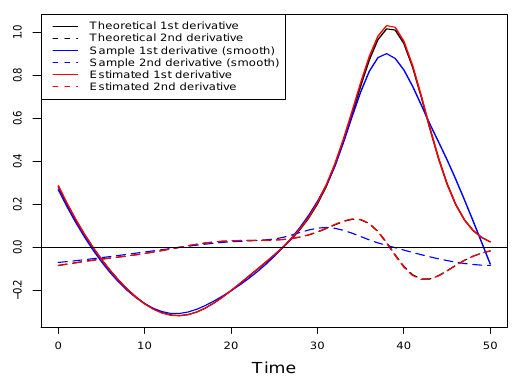
Figure 9. Example 2. Theoretical, sample and estimated inflection time